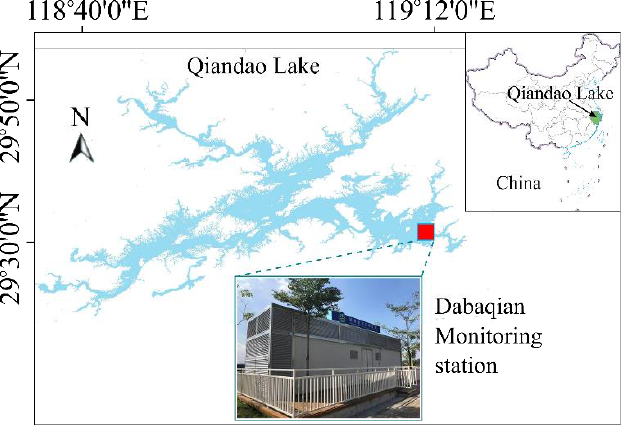
Figure 2. Geographical position of the water quality monitoring station. Table 1. Water quality information